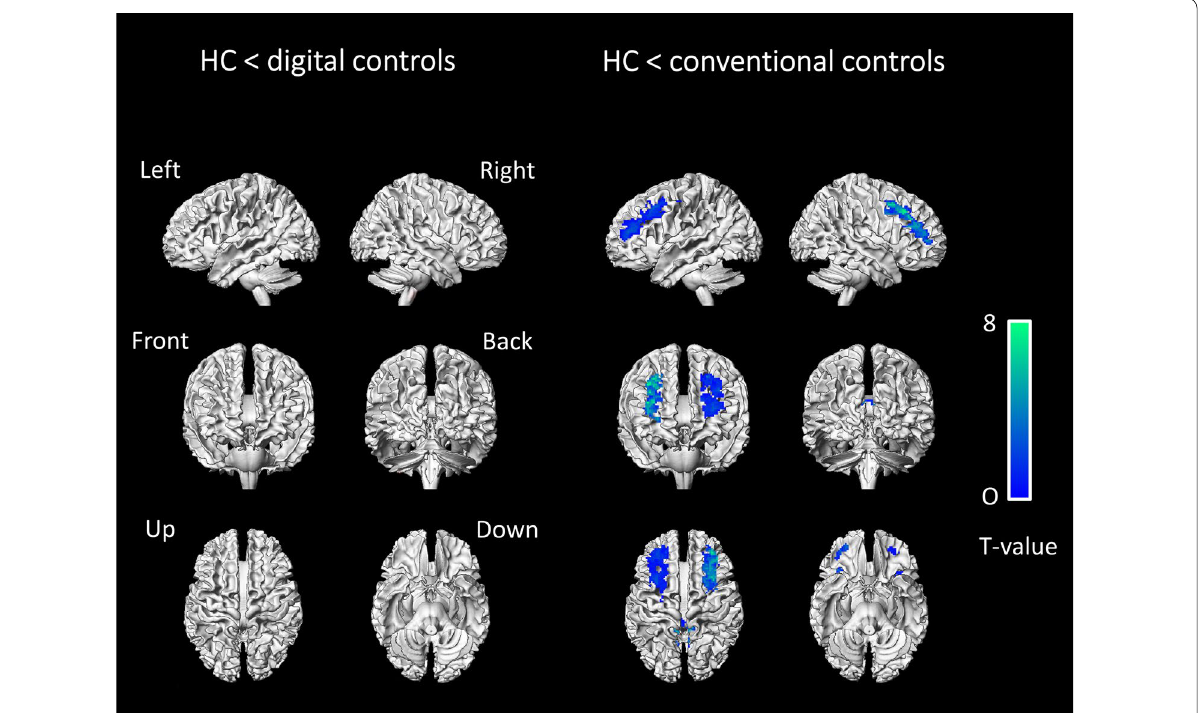
Fig. 3 Anatomical localisation of areas of decreased metabolic activity in HC subjects ( p < 0.001, uncorrected, k > 1.45 cm 3 ), with SQA using digital controls (left panel) and SQA using conventional controls (right panel), projected onto 3D volume rendering, spatially normalised and smoothed into the standard SPM template (T‑voxel threshold value of